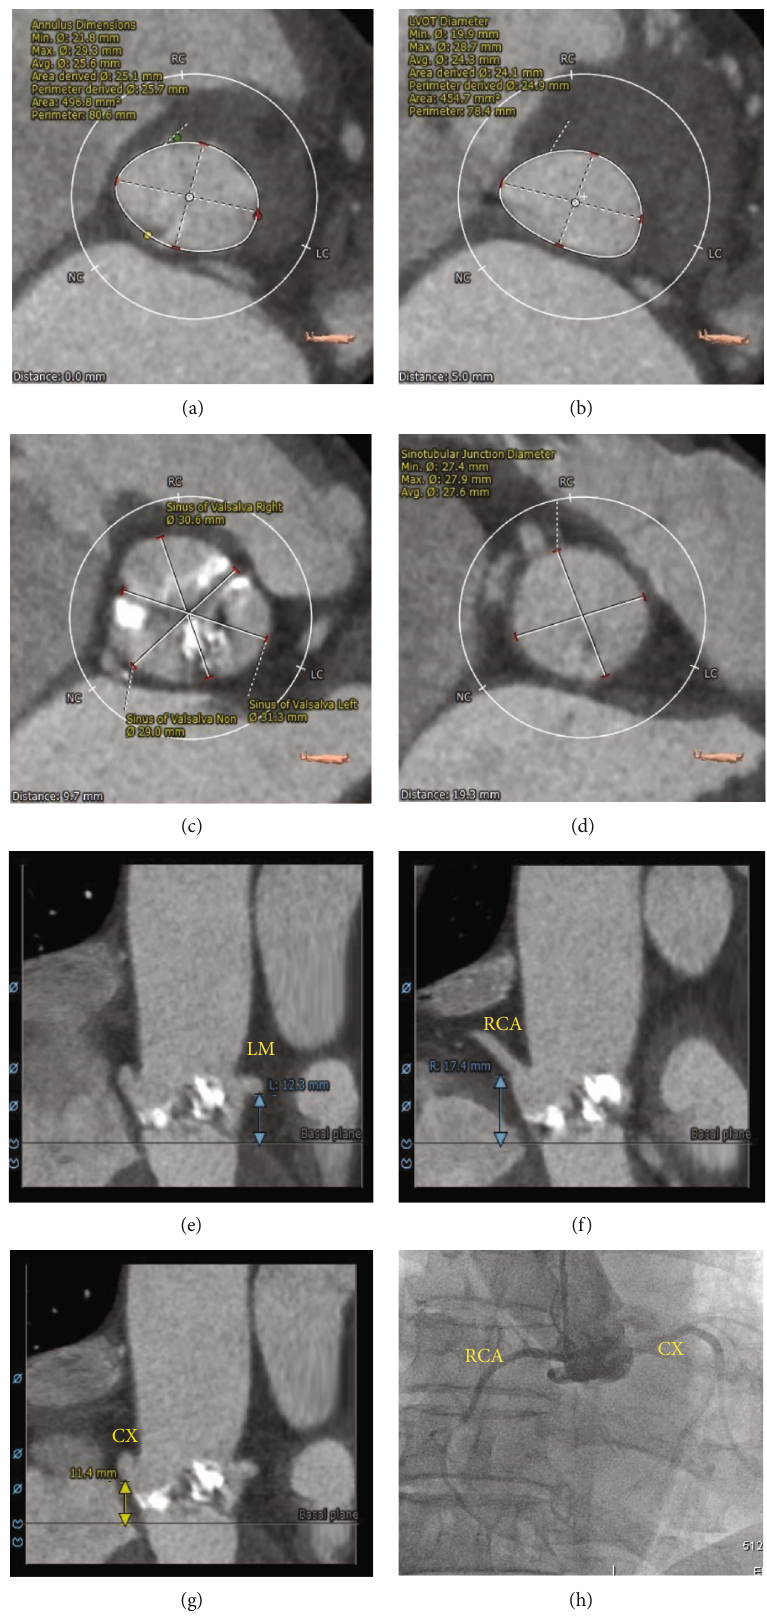
Figure 1: Cardiac computed tomography angiography showed severely calci fi ed aortic lea fl ets with anatomical abnormalities of the right coronary system, which revealed a circum fl ex branch originating from the right coronary sinus, as shown by